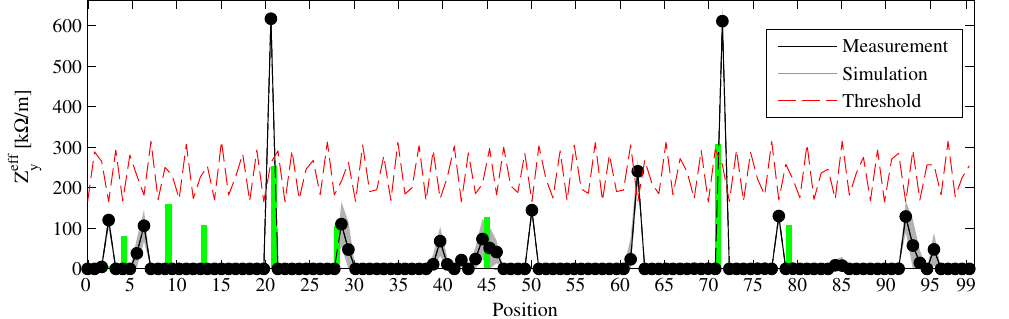
FIG. 10. Comparison between the localized measured and simulated effective vertical impedance, as a function of the impedance reconstruction location along the machine circumference. Considering the noise level in the BPM and the achieved signal amplitude, a threshold for the lowest localizable impedance is deduced.